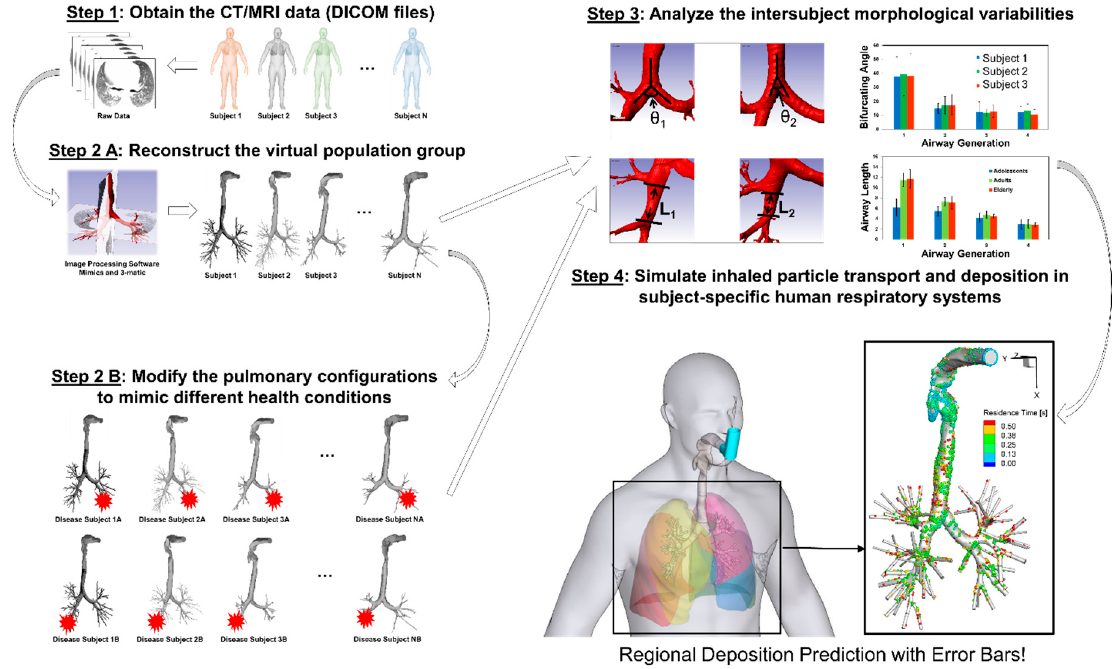
Figure 13. The framework of in silico inter-subject variability study using Computational Fluid-Particle Dynamics (CFPD) models.